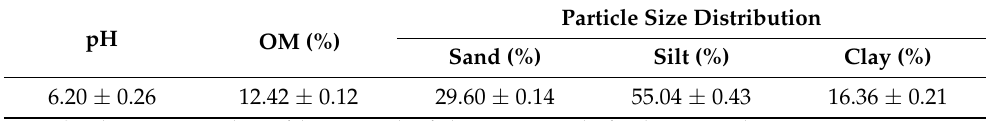
Table 1. Characteristics of tested soils. pH OM (%)